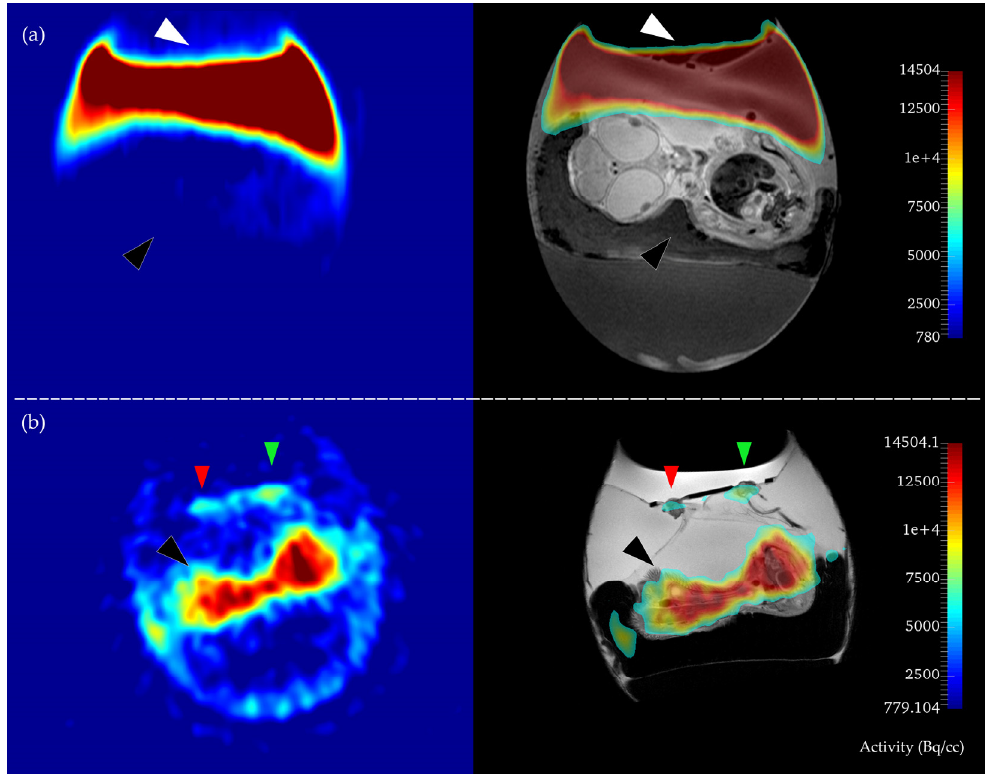
Figure 1. Examples of failed ( a ) and successful ( b ) systemic injection of the radiotracer. The positron emission tomography (PET) image (left side) and the respective PET/MR overlay (right side) are depicted. In ( a ), no tracer accumulation in the embryo can be observed (black arrow), while the whole tracer activity is pooled outside the system on top of the CAM, (white arrow). Thus, this embryo was excluded from further analysis. In ( b ) regular accumulation of the radiotracer in the body of the embryo can be seen (black arrow) without major paravasation. Note also the different intensities of radiotracer accumulation in the xenografts (green and red arrows = PSMA pos., PSMA neg).